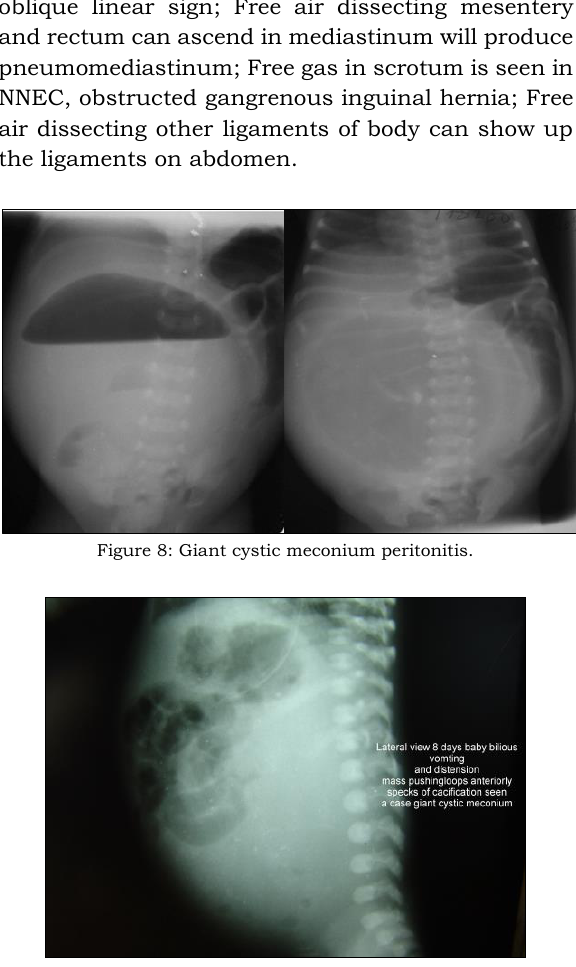
Figure 9: lateral view in giant meconium cyst. Note